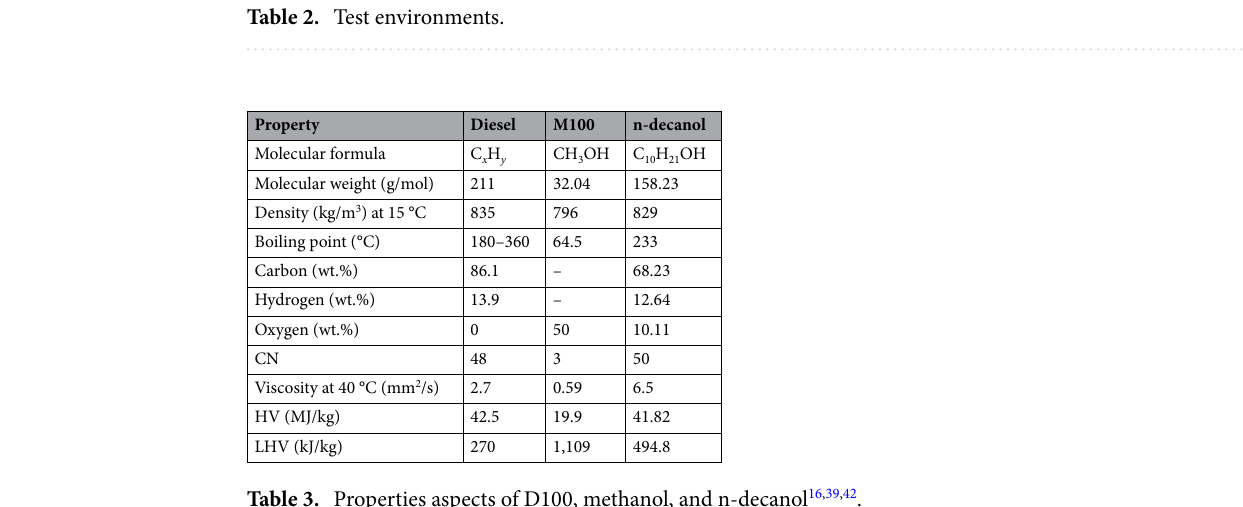
Table 3. Properties aspects of D100, methanol, and n-decanol 16,39,42 .